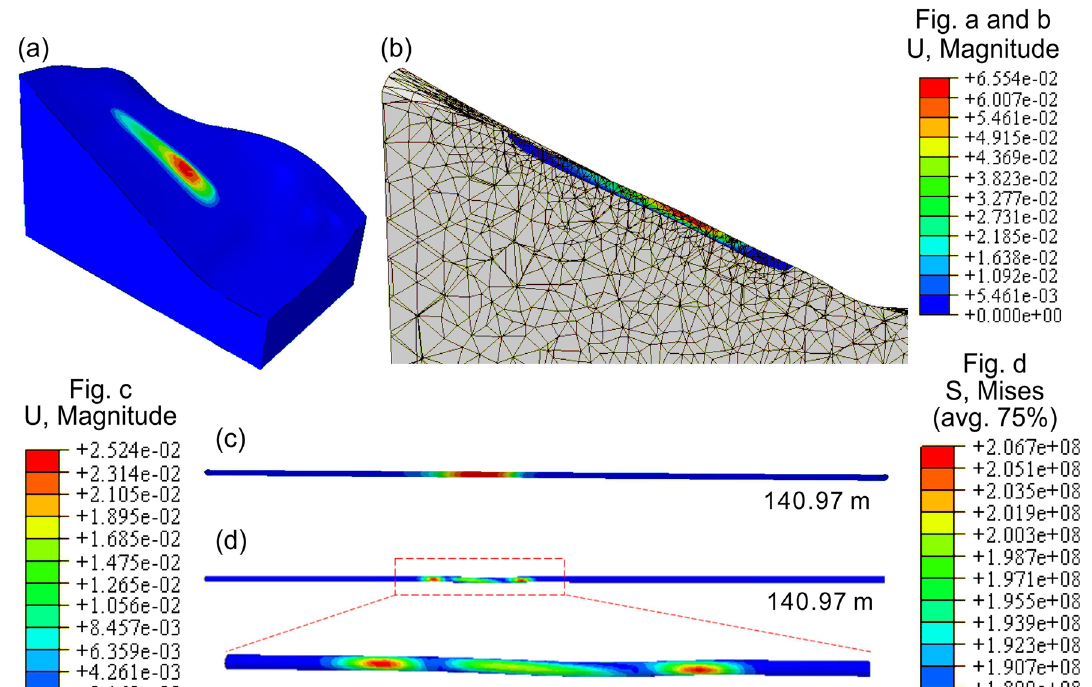
Fig. 9 Finite element simulation results for the impact of the 2015 Xinzhan landslide on the pipeline. a Slope displacement; b slope profile dis- placement; c pipeline displacement; d pipeline